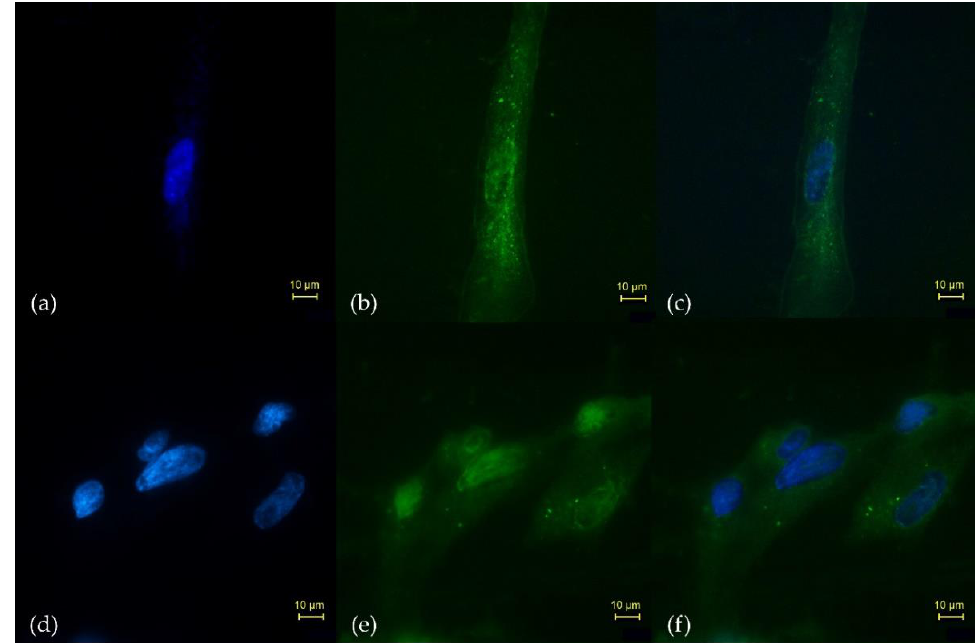
Figure 4. In vitro 99m Tc-iFAP uptake and internalization in N30 (primary human stromal endome- trial cells, FAP positive) and by human fibroblasts (FAP negative control) ( n = 6). * Significant dif- ference, p < 0.05; t -student.